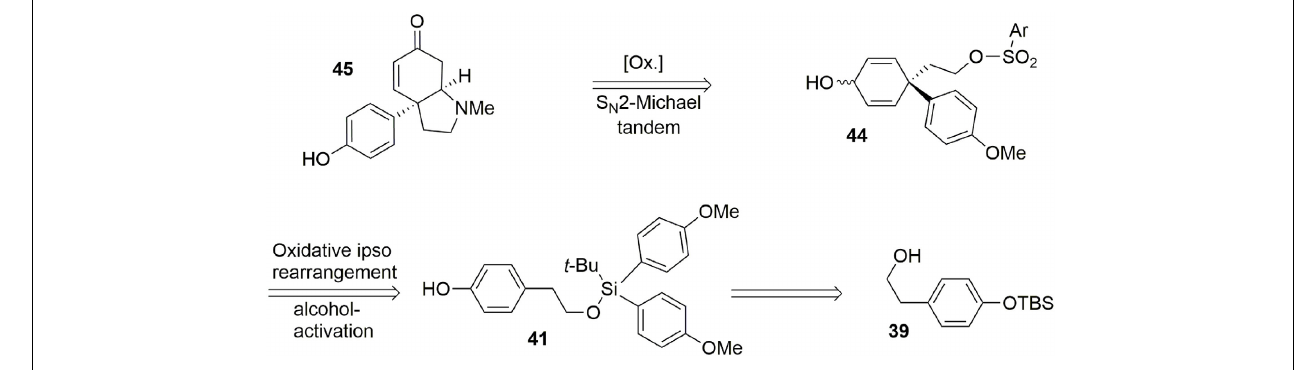
FIGURE 7 | Retrosynthesis of sceletenone.